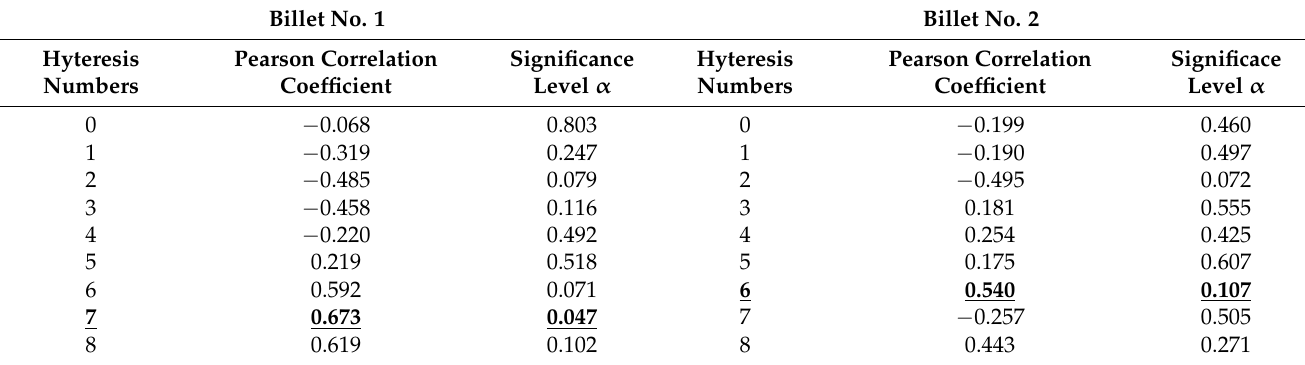
shown in ( c ). Table 2. Pearson correlation coefficient under different hysteresis numbers of billet No. 1 and billet No. 2.